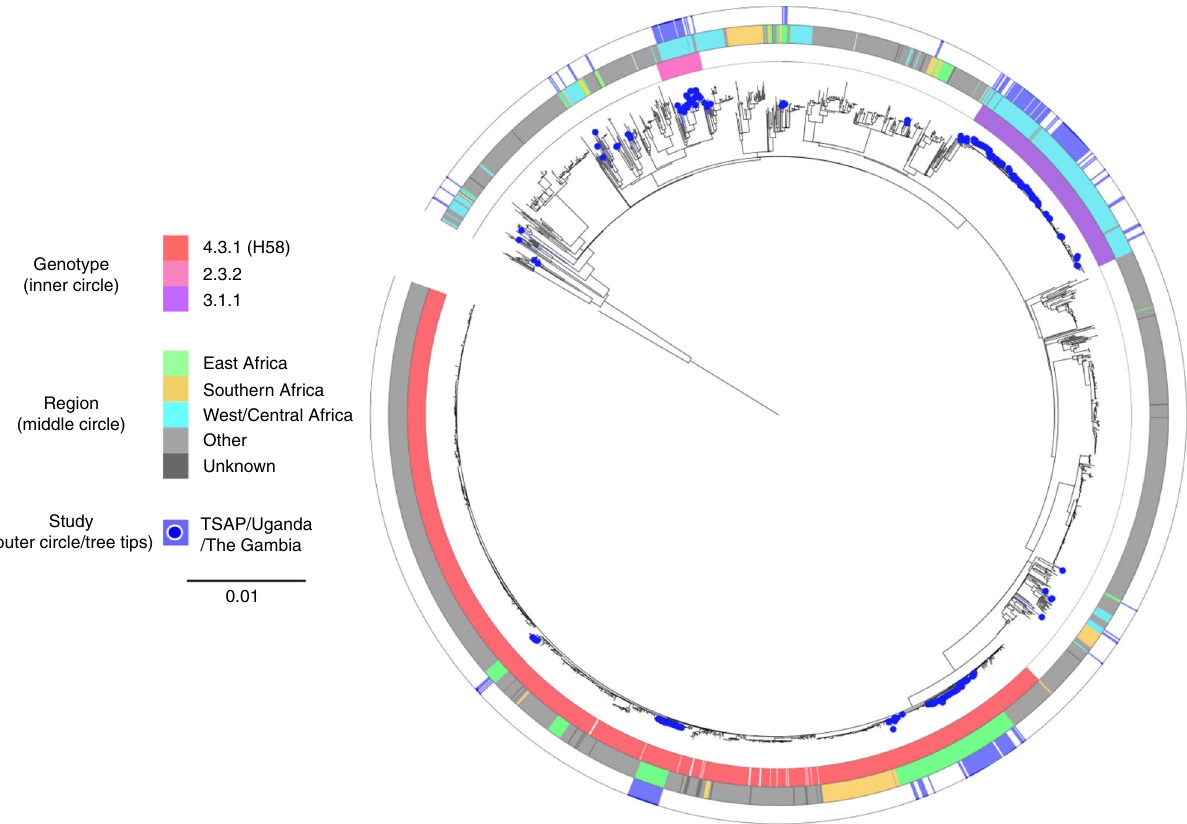
Fig. 1 The phylogenetic context of Salmonella Typhi isolated in sub-Saharan Africa. Maximum likelihood tree outlining the phylogenetic structure of 249 S . Typhi isolates unique to this study (highlighted by the blue points) combined with 2,057 global S . Typhi isolates. The tree is adjacent to three concentric circles highlighting associated metadata. The inner most circle represents the three most predominant genotypes (colour coded according to top of key), the middle circle represents the geographical sub-regions of Africa from where the S . Typhi organisms were isolated (colour coded according to top of key), and the outer circle (blue) again highlights the organisms unique to this study. The scale bar indicates the number of substitutions per variable